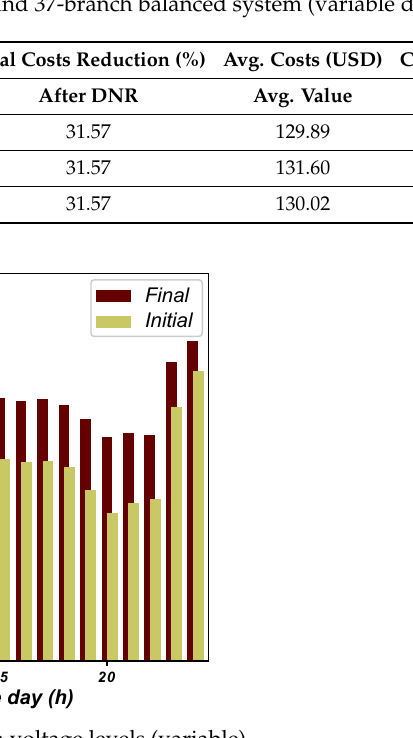
Table 5. Results found for the 33-bus and 37-branch balanced system (variable demand).